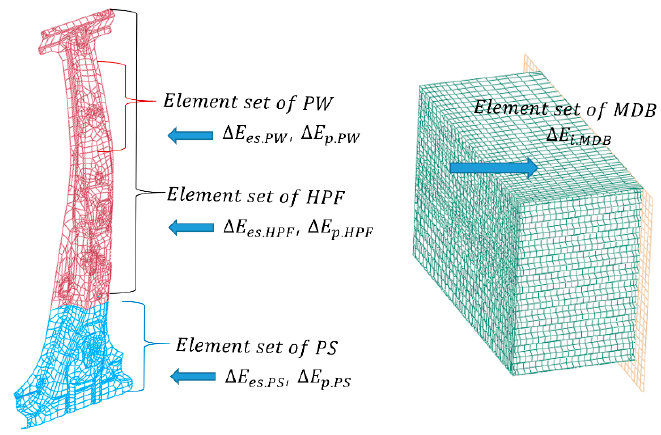
Figure 8. Energy distribution of the center pillar and MDB.